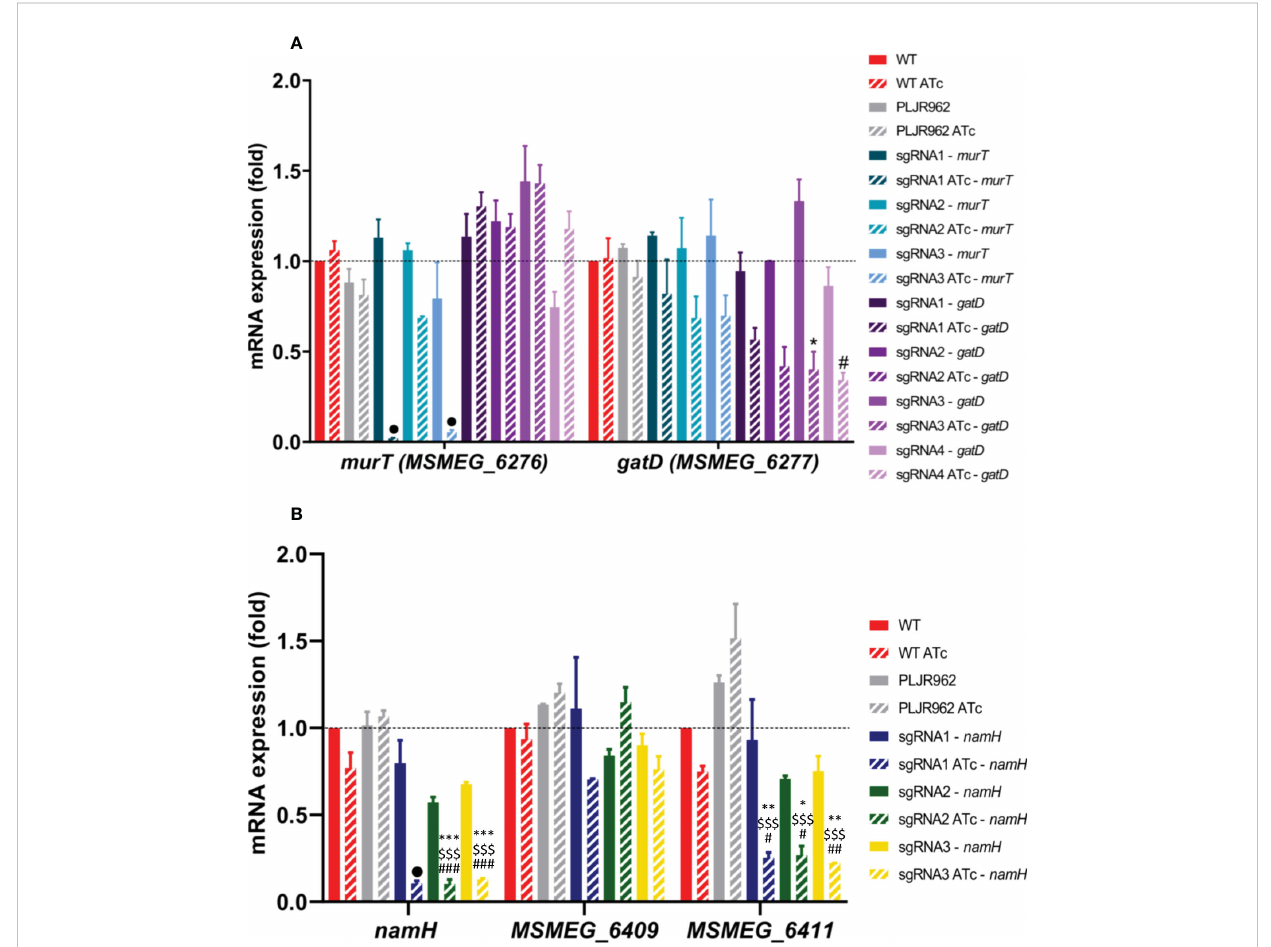
FIGURE 3 Results of qRT-PCR assays for the single mutants, constructed in the M. smegmatis WT strain (n=2): (A) murT (blue shade bars) and gatD (purple shade bars) knockdown mutants; (B) namH knockdown mutants. The graph shows the mean of the relative mRNA expression of genes of interest normalized to sigA , at 6 hours post-induction, with (stripped bars) and without (smooth bars) ATc. The dashed lines show the WT sample as calibrator. Error bars show the standard error of the mean. Multiple comparisons were made using one-way ANOVA, with signi fi cance levels: * P < 0.05; ** P < 0.01; *** P < 0.001. Signi fi cant differences are indicated with symbols: # comparing to the induced WT strain (WT ATc), $ comparing to the induced control M. smegmatis :PLJR962 (PLJR962 ATc), * comparing to the respective uninduced strain. The (cid:129) symbol indicates a highly signi fi cant difference ( P < 0.0001) from all